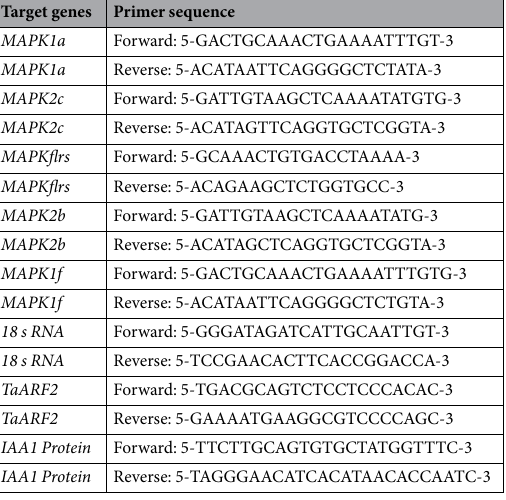
Table 1. Full-length of MAPK , TaARF2 and IAA -encoding